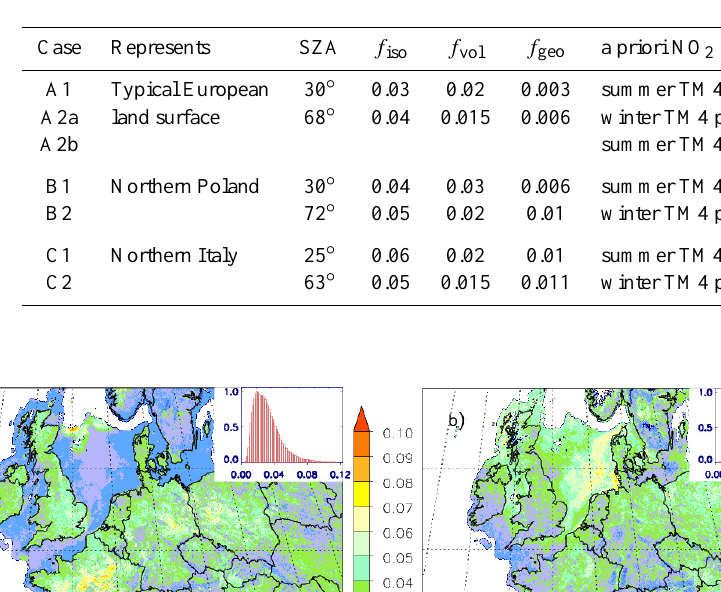
Table 1. Retrieval settings for selected scenarios, with representative solar zenith angles and BRDF coefficients for July and November. The a priori NO 2 profiles are shown in Fig. 7.